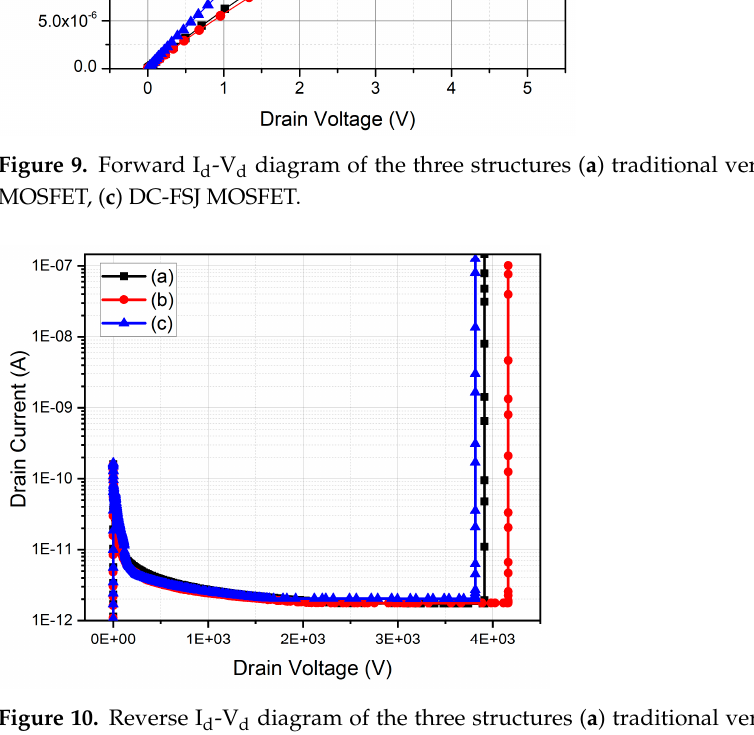
Figure 10. Reverse I d -V d diagram of the three structures ( a ) traditional vertical MOSFET, ( b ) FSJ MOSFET, ( c ) DC-FSJ MOSFET.